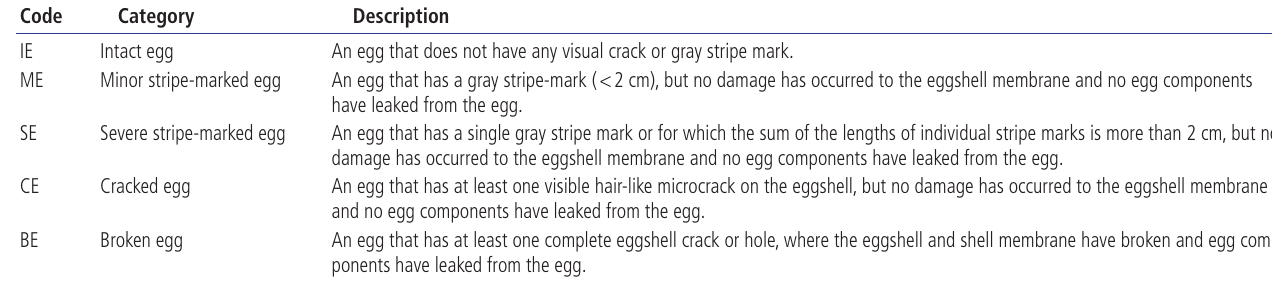
Table 1. Description of various types of eggs analyzed Code